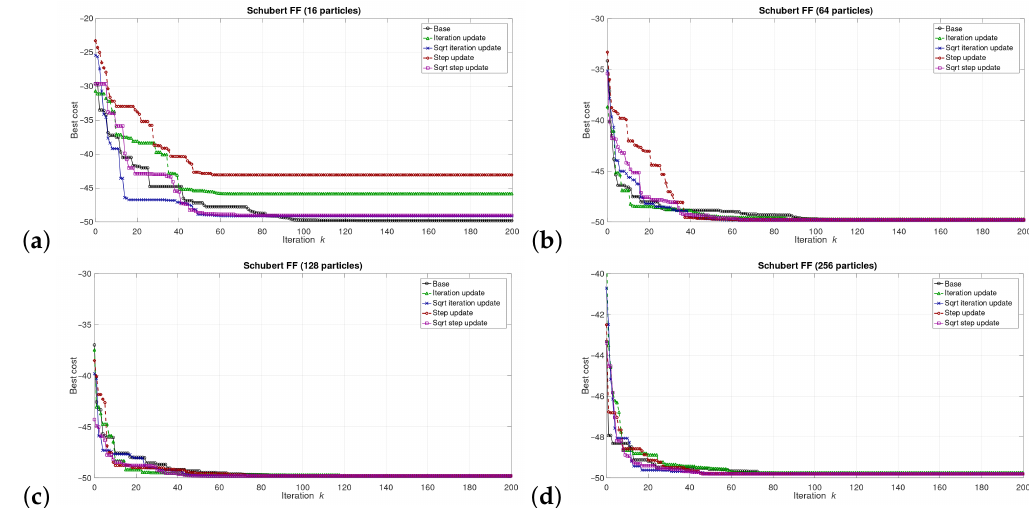
Figure 9. Selected results for Schubert FF for ( a ) 16, ( b ) 64, ( c ) 128, and ( d ) 256